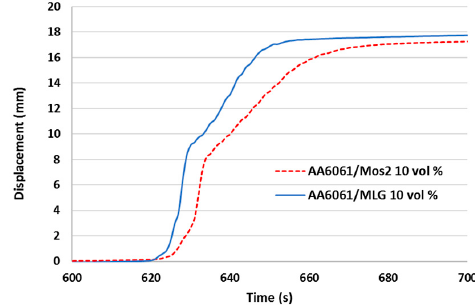
Figure 10. Displacement of punch for AA6061/MLG 10 vol % (blue solid line) and AA6061/MoS2 10 vol % (red dotted line) during the SPT ( λ = 1.5) process.